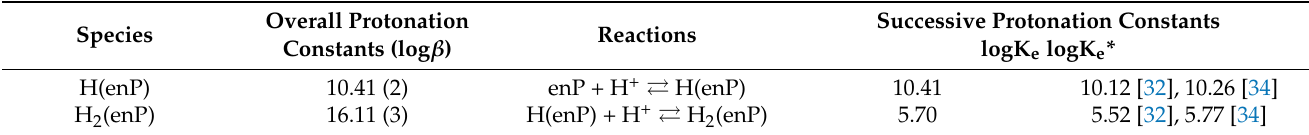
Table 2. Overall and successive protonation constants of enP (standard deviation is given in parenthesis). Species